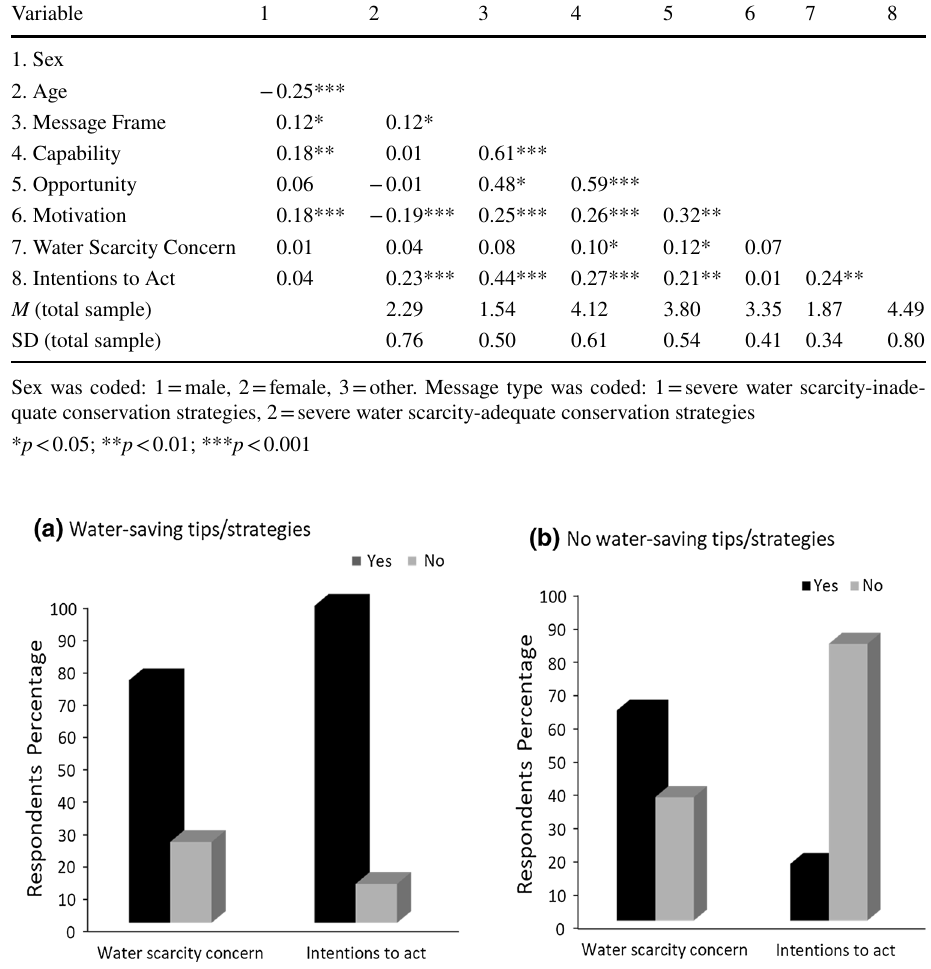
Table 2 Zero-order correlations and descriptive statistics for all study variables ( N = 510)